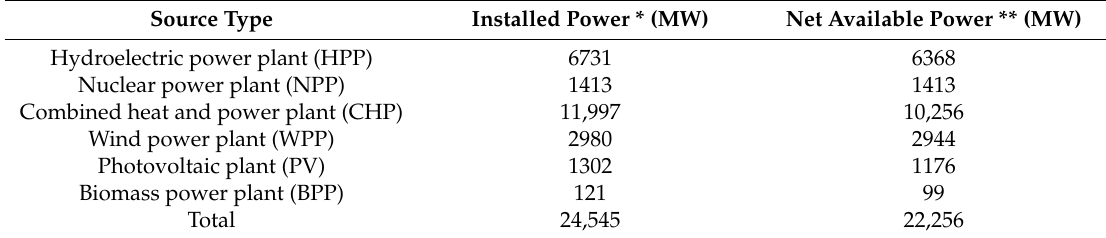
Table 1. Net available power from power plants in the national power system.